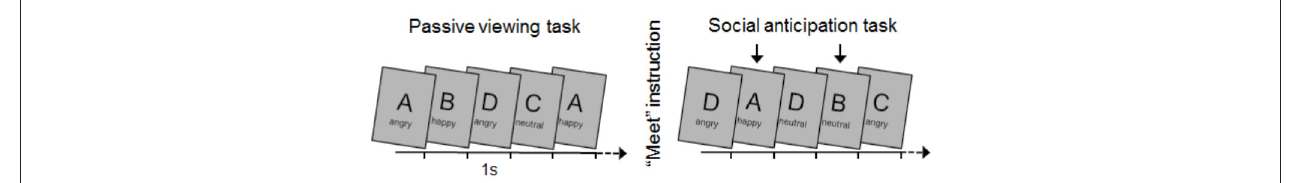
Following picture ratings, the main instruction about social contingencies was given: “You are going to meet one of these two people at the end of the experiment” (here indicated by an arrow). Finally, participants again rated face stimuli and were